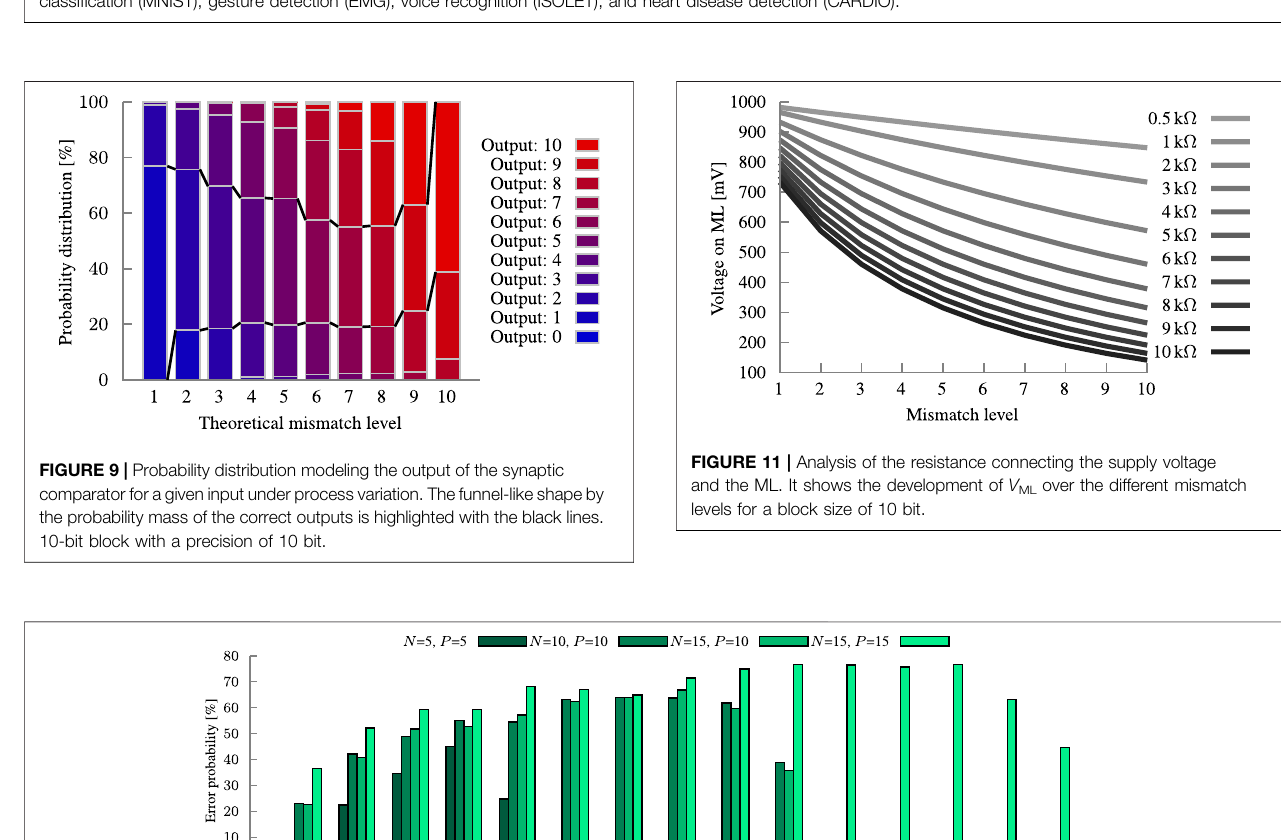
FIGURE 8 | Inference accuracy loss of fi ve different applications based on the 10-bit block with 10-bit precision error model. We use language recognition, image classi fi cation (MNIST), gesture detection (EMG), voice recognition (ISOLET), and heart disease detection (CARDIO).